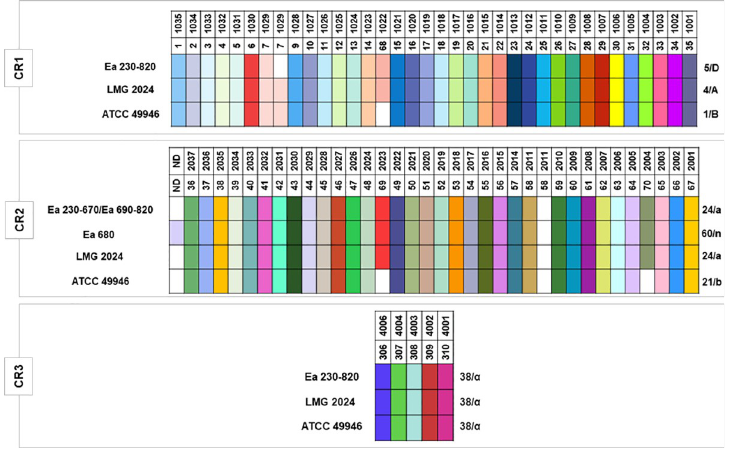
Fig 3. CRISPR arrays patterns of the 36 Portuguese Erwinia amylovora isolates and type strain LMG 2024. CR1/2 and 3 array patterns for the strains ATCC 49946, were retrieved from McGhee and Sundin [40] and Rezzonico et al. [39]. Isolates identification are listed on the left of each color pattern. Each spacer is represented by a single color for each CRISPR array. Spacers were considered unique if they contained at least 5 nucleotide differences compared to other spacers. Each spacer is identified by a color and a number in the upper side of each CR. Spacers that are equal are aligned in column for the different isolates in study. The blank intervals represent a spacer that it is not present in that CR pattern. Patterns/genotypes are identified by a number and a letter respectively in the right side of the color pattern. Nomenclature of each spacer, and pattern/genotype were based on the classification of McGhee and Sundin [40], and Rezzonico et al. [39],